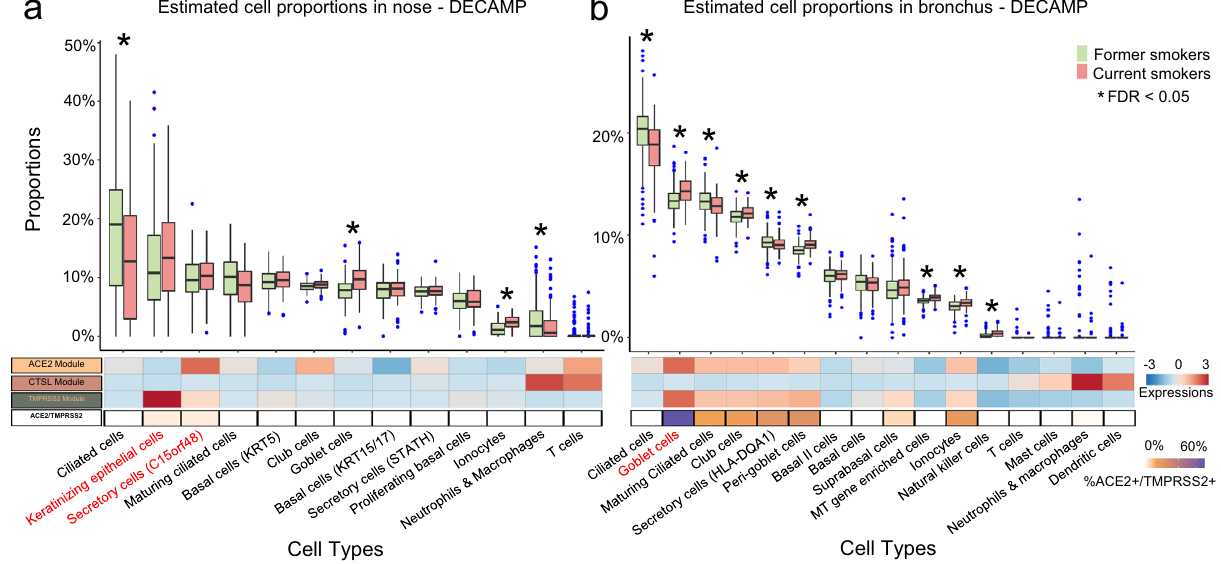
Figure 4. Deconvolution of bulk RNA-seq data shows increased proportions of goblet cells in nasal brushings from current smokers and goblet cells, peri-goblet cells, and ionocytes in bronchial brushings from current smokers. ( a, b ) Top: boxplots of cell type proportions estimated by AutoGeneS in bulk RNA-seq data from nasal (n = 281) and bronchial brushings (n = 355) obtained from current and former smokers in the DECAMP cohort. Significant cell proportion differences between current and former smokers were determined by the Wilcoxon test (* indicates FDR q < 0.05). Bottom: the heatmap displays the average VE module score for each cell population from the single-cell RNA-seq data (first three rows), as well as the proportion of each cell type that is ACE2 + /TMPRSS2 + (i.e., the expression of both genes is one standard deviation above the average). Cell types that express both ACE2 and TMPRSS2 modules are in red. Prevalence of cell types enriched for ACE2 and TMPRSS2 expression shows positive correlation with smoking only in the bronchus, which may explain the lack of association of ACE2/TMPRSS2 expression between the bronchial and nasal bulk RNA-seq